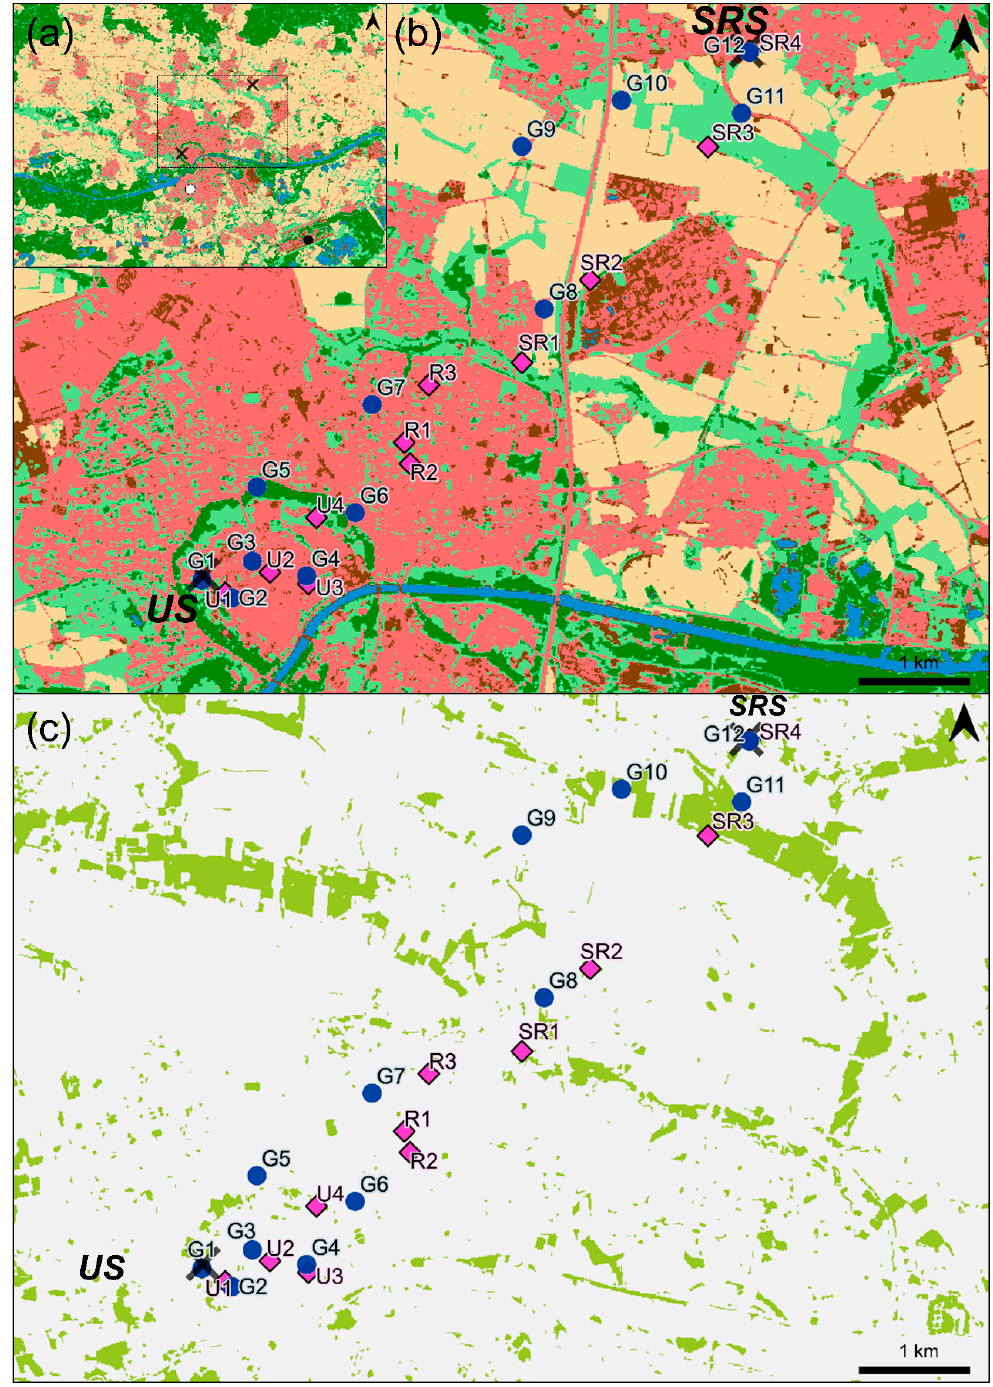
Figure 1. Locations of pollen traps: Blue circles—gravimetric traps; pink squares—PVAS; black crosses—volumetric pollen traps (roof level); ( a ) Study area (dashed box) and surrounding land use; white circle—station measuring precipitation (LfU); black circle — weather station (DWD); ( b ) Land use 2019: dark green — forest; light green — low vegetation; blue — water; red — built-up; dark brown — bare soil; light brown — agriculture [45]; ( c ) Grassland 2018: green — grass area [46].